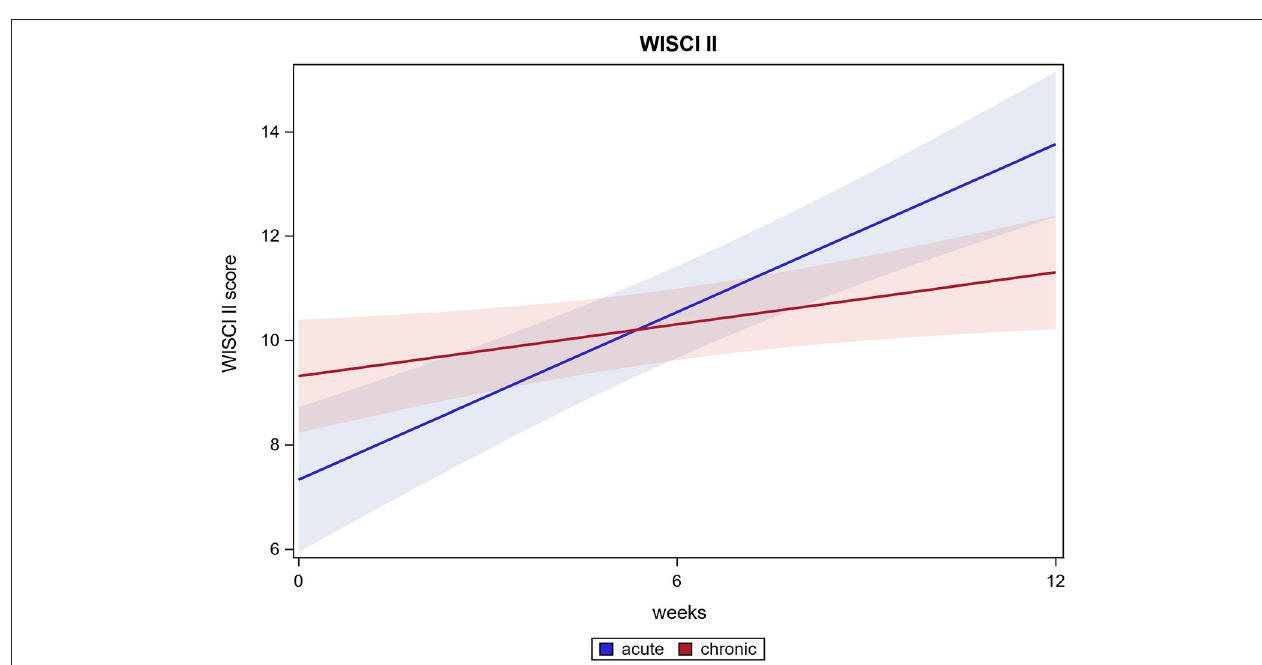
FIGURE 2 | Six minute walk.